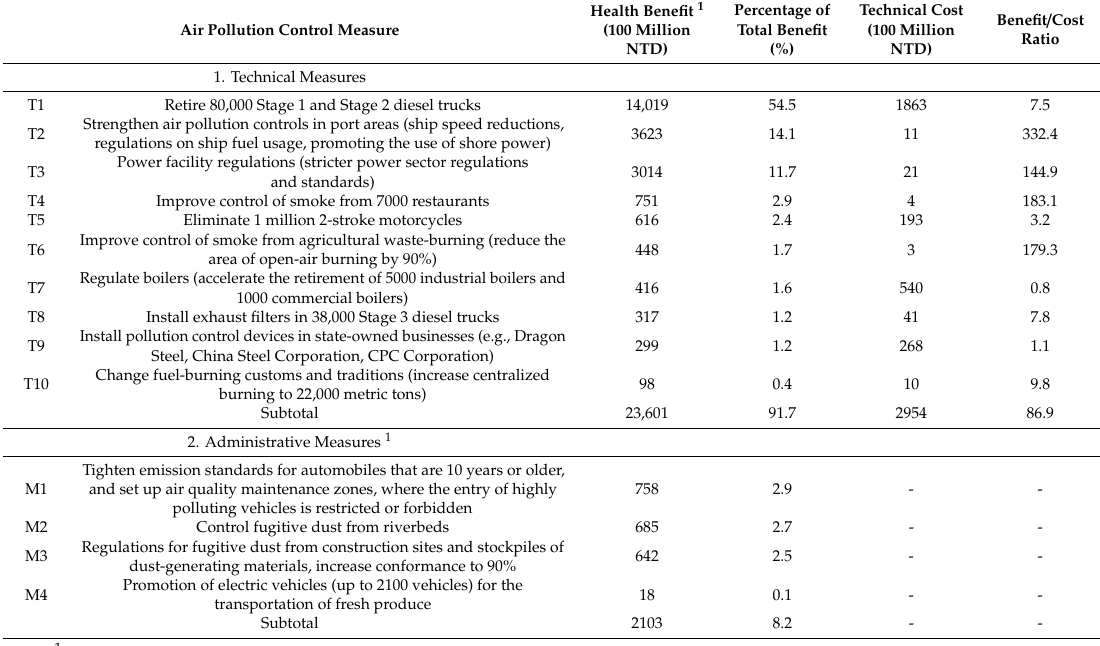
Table 4. Health benefit of each pollution control measure under the 14 air pollution control strategies (TAPCAP).